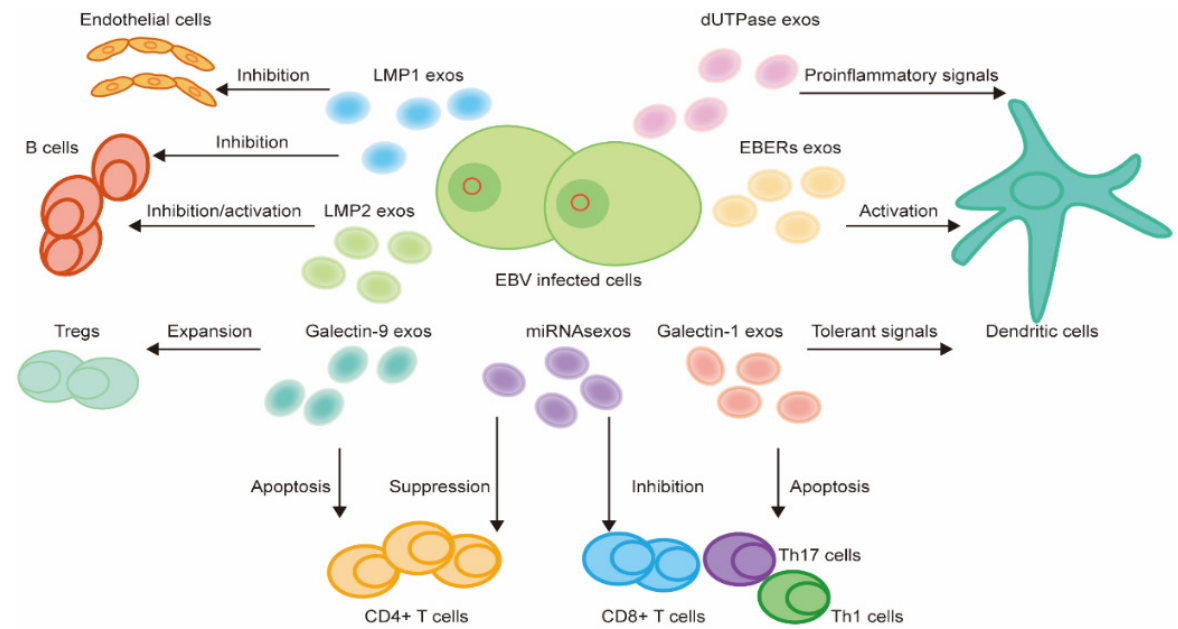
Figure 3. Extracellular vesicles released by EBV-infected cells. The EBV-infected cells release exosomes (exos), containing different components, such as LMP1, LMP2, EBERs, miRNAs, galectin-1, galectin-9, and dUTPase. These extracellular vesicles interact with different immune cells to form a supportive and immunosuppressive tumor microenvironment.